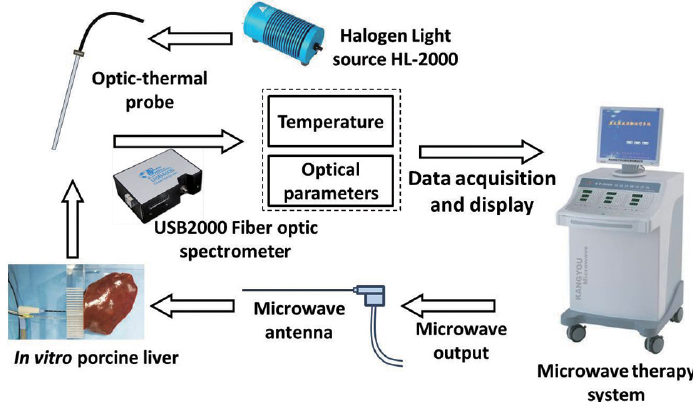
Fig. 1. System setup for MWA and real-time data acquisition.